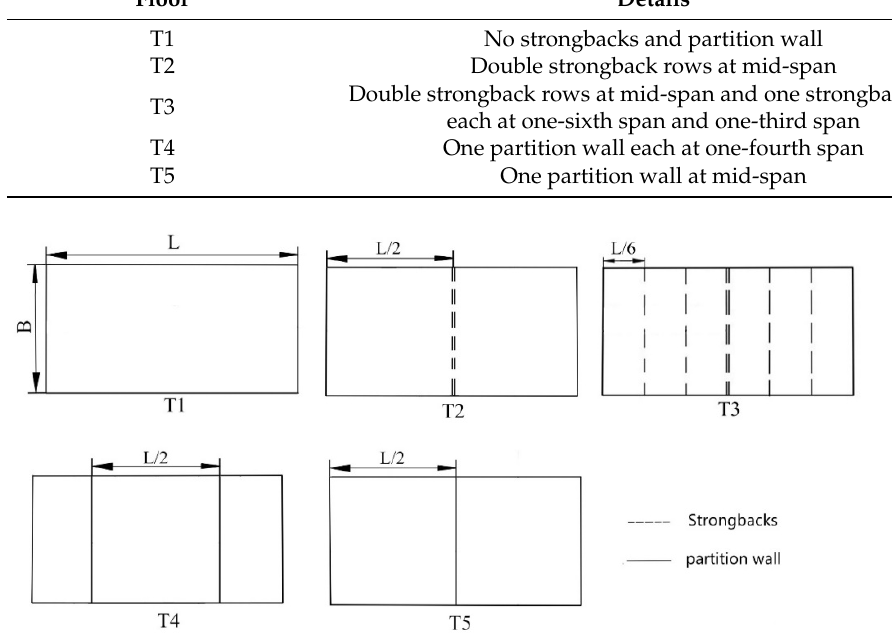
Figure 5. Schematic representation of test floors.